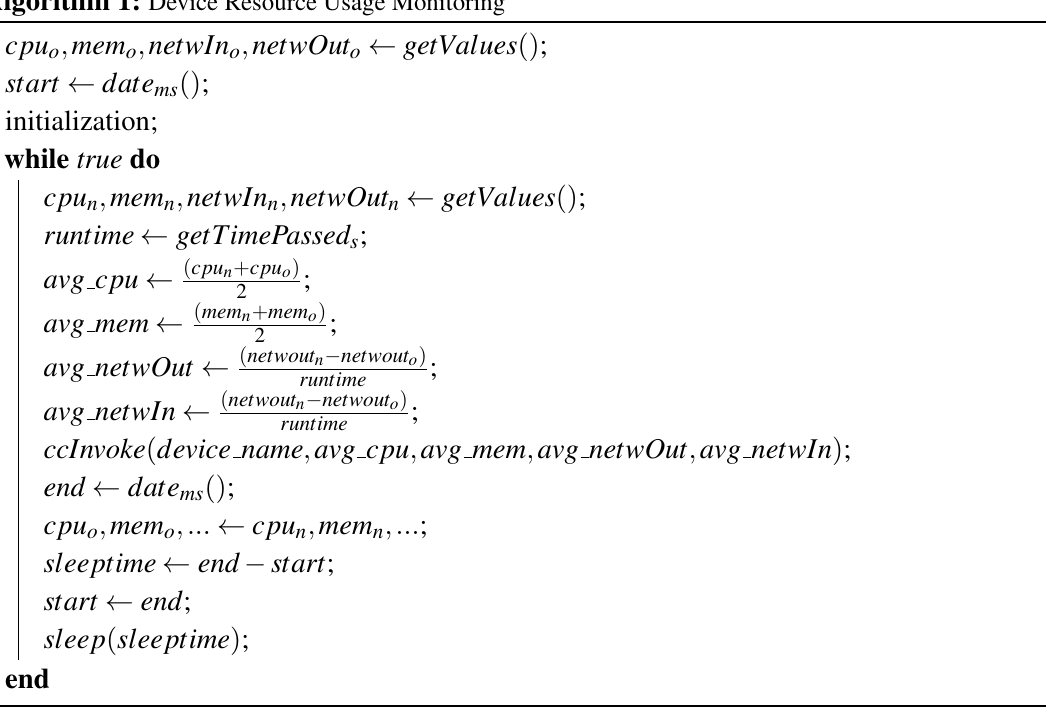
Algorithm 1: Device Resource Usage